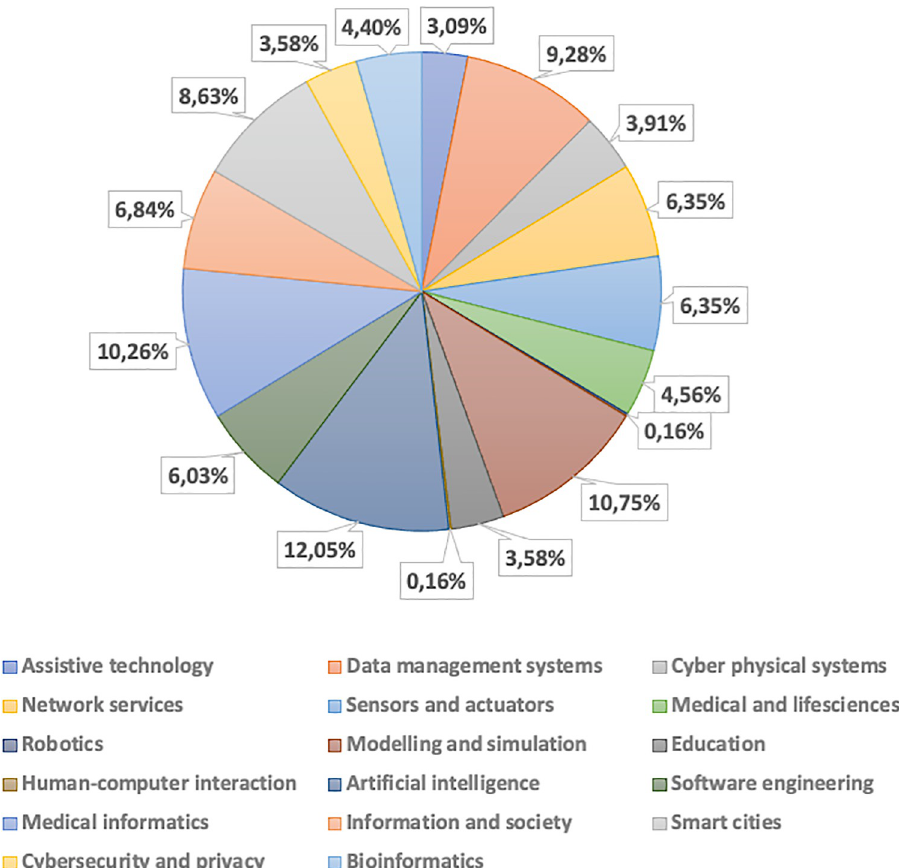
Fig 7. Statistics on the number of activities in the scientific